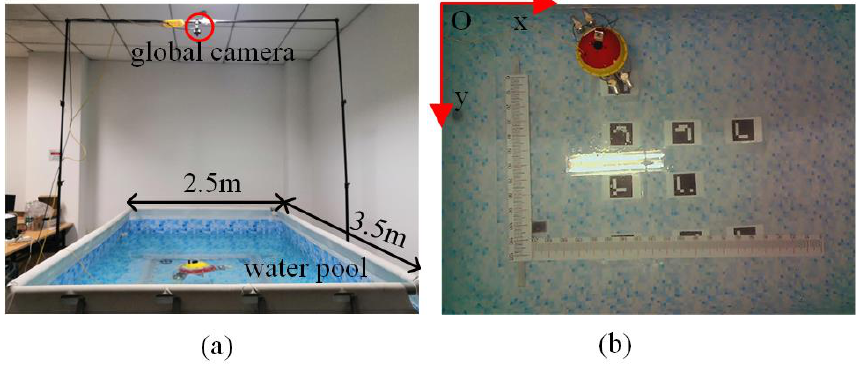
Figure 18. Experiment set up for biomimetic sphere robot (BSR) trajectory tracking. ( a ) Experiment setup. ( b ) Image of water pool in the view of global camera